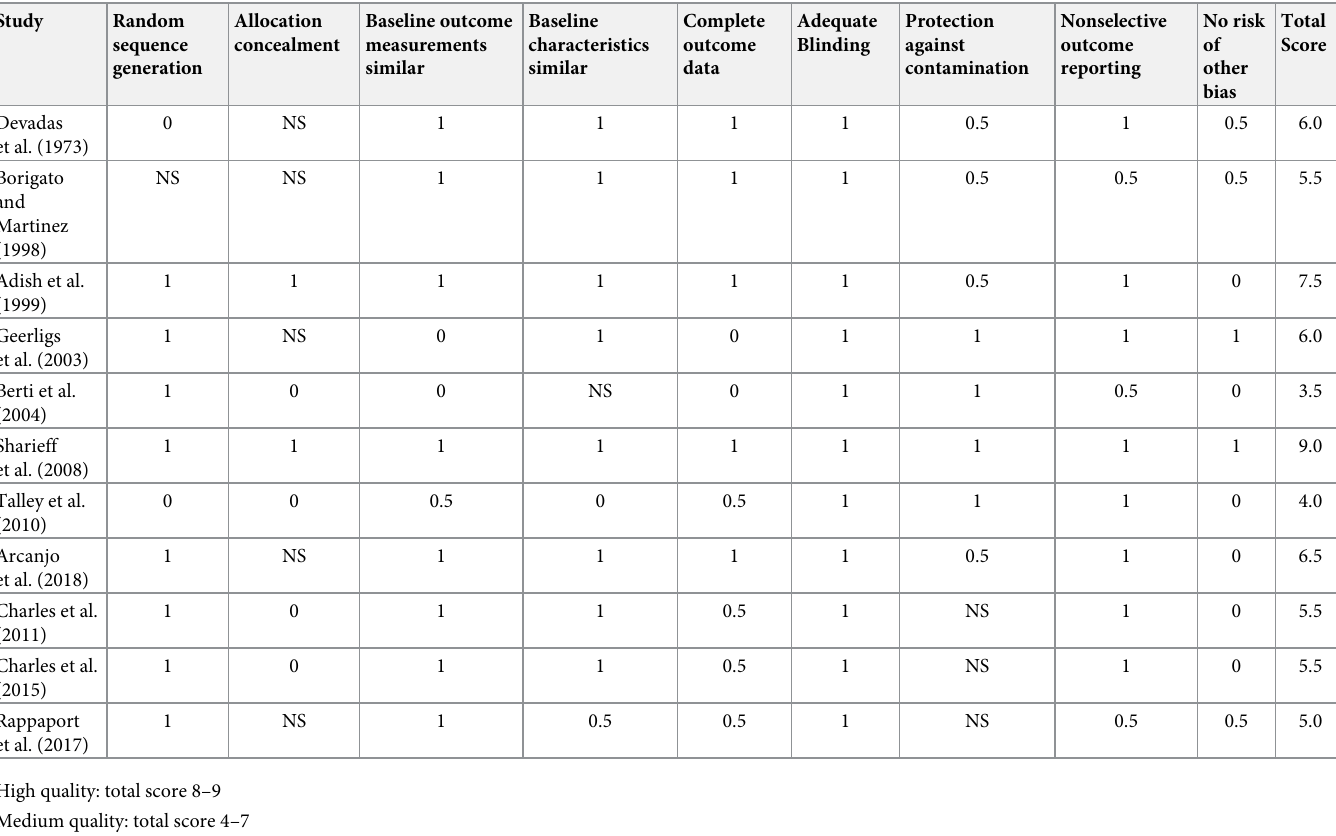
Table 4. Quality assessment of included